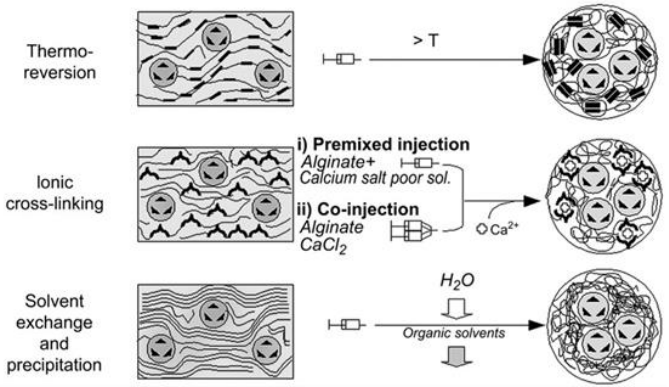
Figure 4. Schematic representation of three possible injection mechanisms for in situ hydrogelation of magnetogels. Reprinted from [75] with permission from Elsevier, 2010.